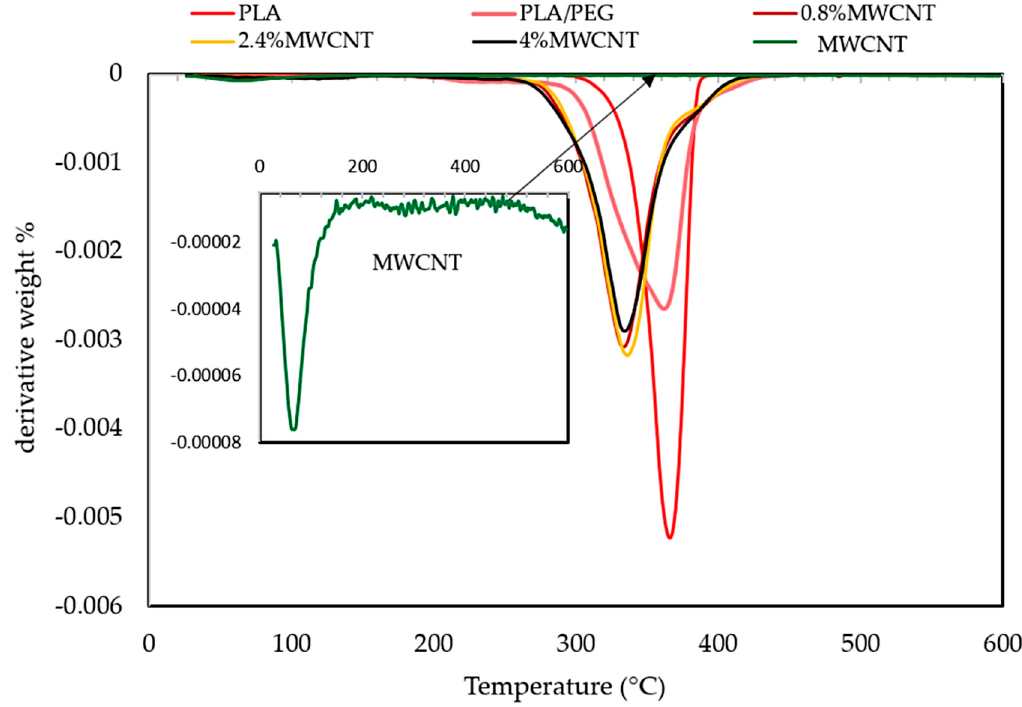
Figure 8. Thermogravimetric (DTG) curves of neat PLA, PLA / PEG blend, MWCNTs powder, and nanocomposites with different MWCNTs loading (0.8 wt.%, 2.4 wt.% and 4 wt.%).